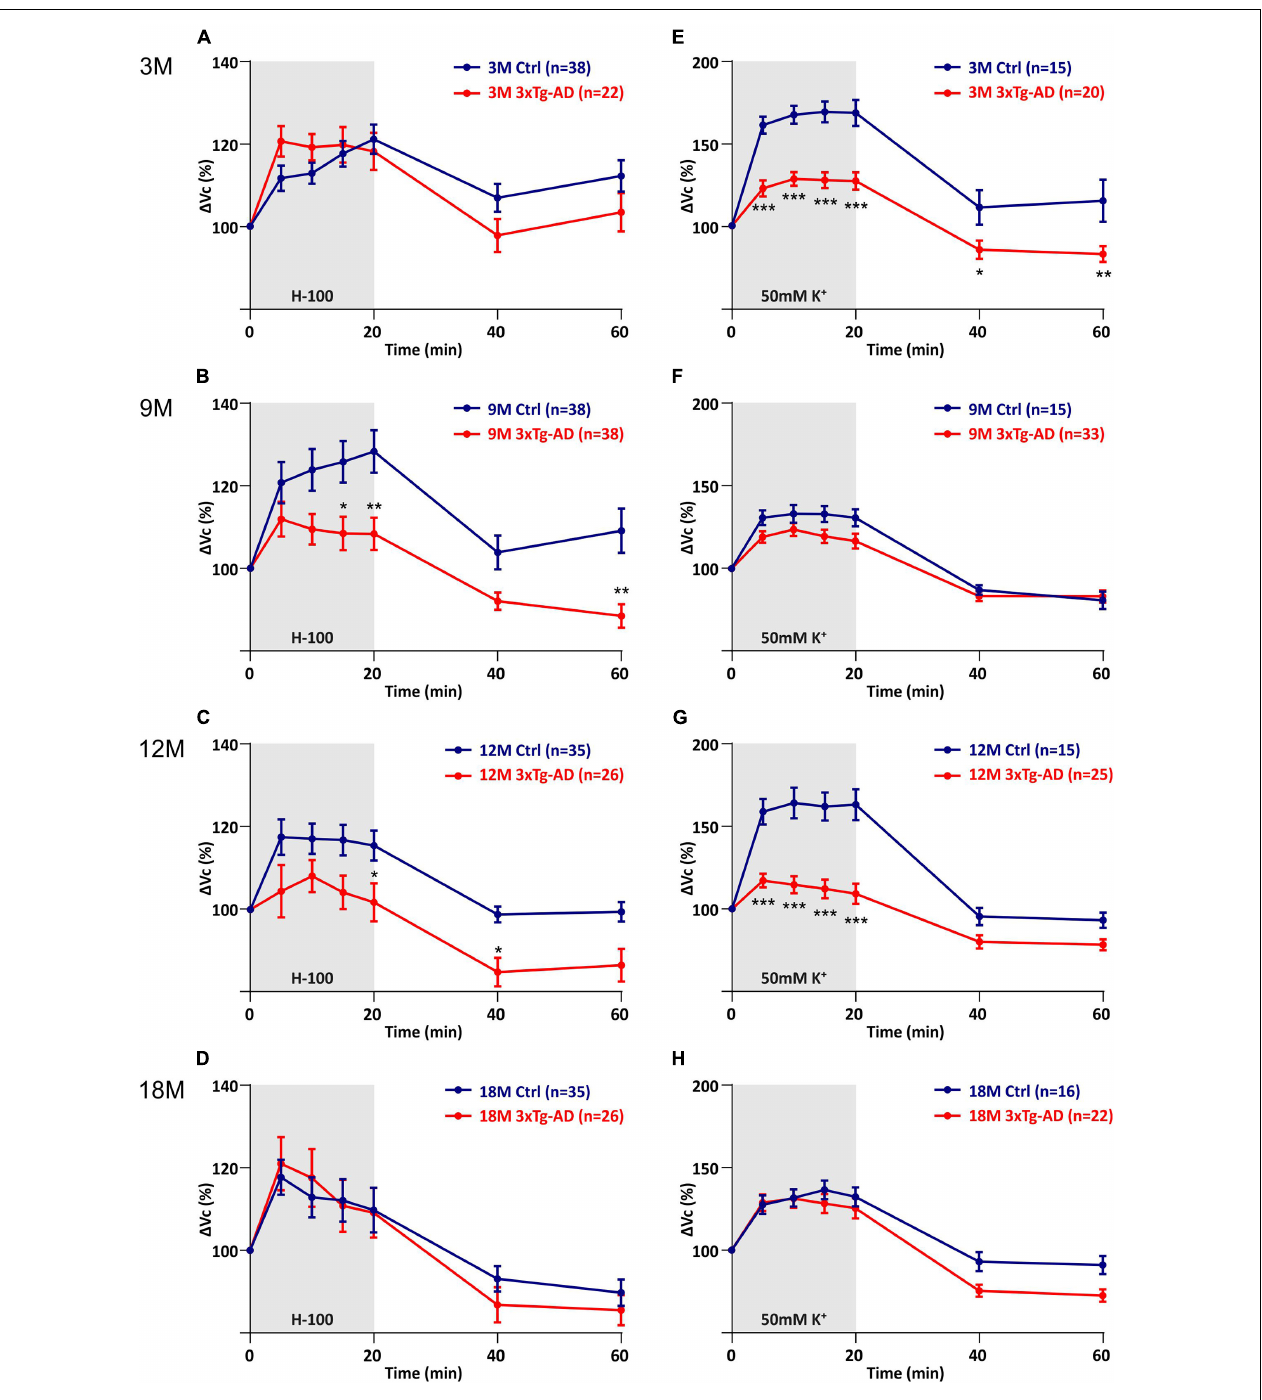
FIGURE 6 | Comparison of astrocyte swelling in controls and 3xTg-AD during exposure to hypo-osmotic stress or severe hyperkalemia (50 mM K + ). (A–D) Time course of the total volume changes ( (cid:49) Vc) in EGFP-positive cells during a 20-min application of aCSF H − 100 and a 40-min washout. Note that the astrocyte swelling is comparable in 3M- and 18M-old animals, while the astrocytic swelling in 9M- and 12M-old controls significantly exceeds the swelling in 3xTg-AD. (E–H) Time course of the total volume changes ( (cid:49) Vc) in EGFP-positive cells during a 20-min application of aCSF K + and a 40-min washout. Note that the astrocyte swelling is comparable in 9M- and 18M-old animals, while the astrocytic swelling in 3M- and 12M-old controls significantly exceeds the swelling in 3xTg-AD. Data are presented as mean ± SEM. Statistical significance was determined by two-way ANOVA with Tukey’s multiple comparison test. Asterisks indicate significant differences (* p < 0.05, ** p < 0.01, *** p < 0.001). Ctrl, control; 3xTg-AD, triple transgenic model of AD crossbred with GFAP/EGFP mice; GFAP, glial fibrillary acidic protein, EGFP, enhanced green fluorescent protein; aCSF, artificial cerebrospinal fluid; H-100, hypotonic artificial cerebrospinal fluid; 50 mM K + , artificial cerebrospinal fluid with elevated K + concentration; 3M, 9M, 12M, 18M, 3-, 9-, 12-, 18-month-old animals; n, number of cells.